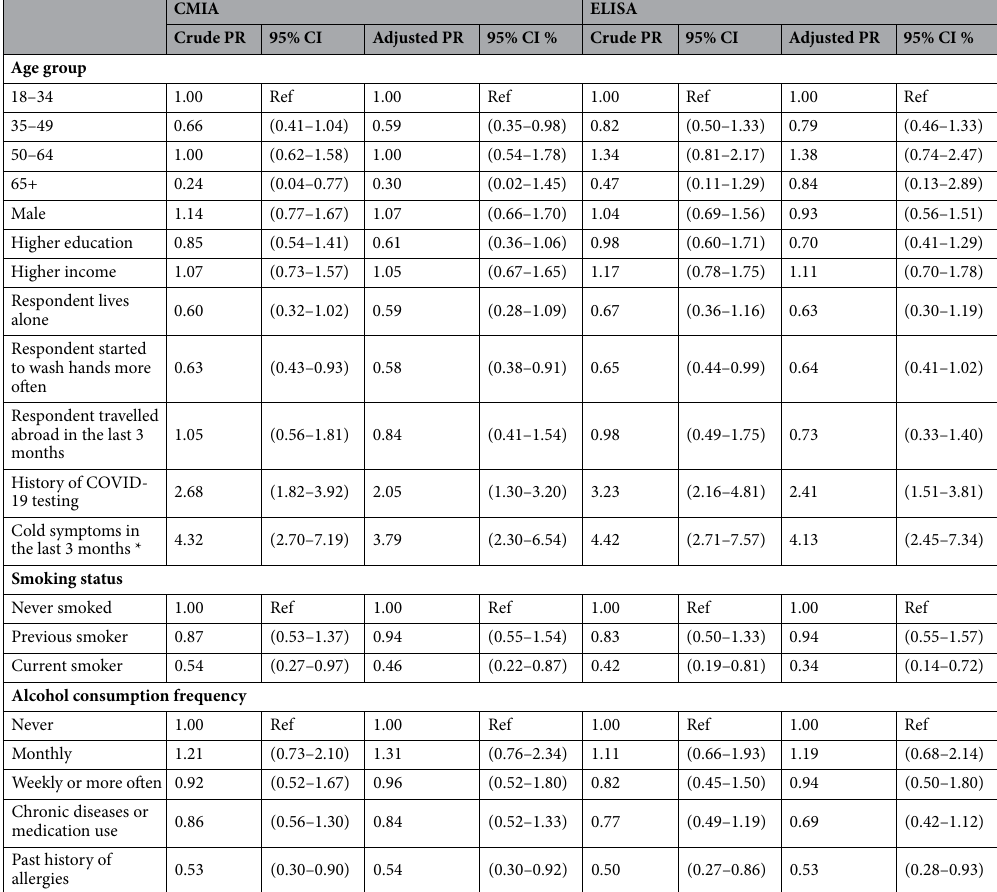
of illness in the last 3 months” in the phone-based